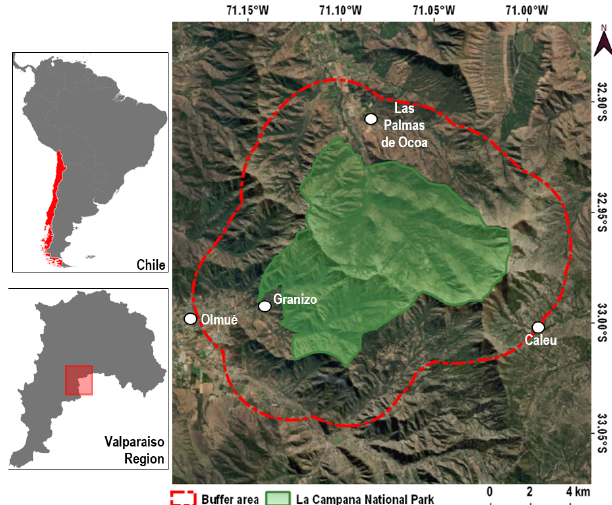
Figure 2 . La Campana National Park where the web-platform was implemented in December